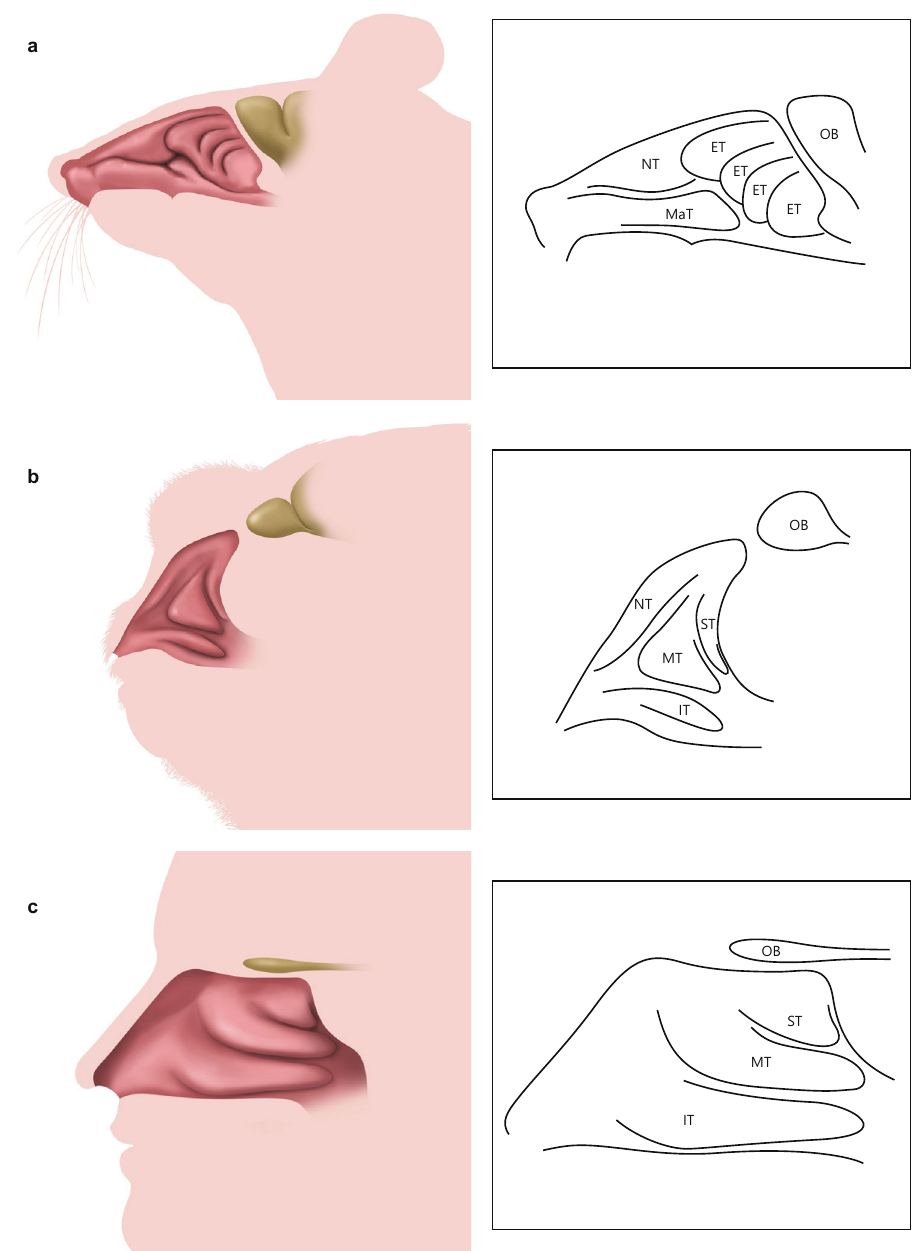
Fig. 3 Schematic drawings of the nasal structures of the mouse, common marmoset and human. a Mouse. b Common marmoset. c Human. ET ethmoturbinate, IT inferior turbinate, MaT maxilloturbinate, MT middle turbinate, NT nasoturbinate, OB olfactory bulb, ST superior